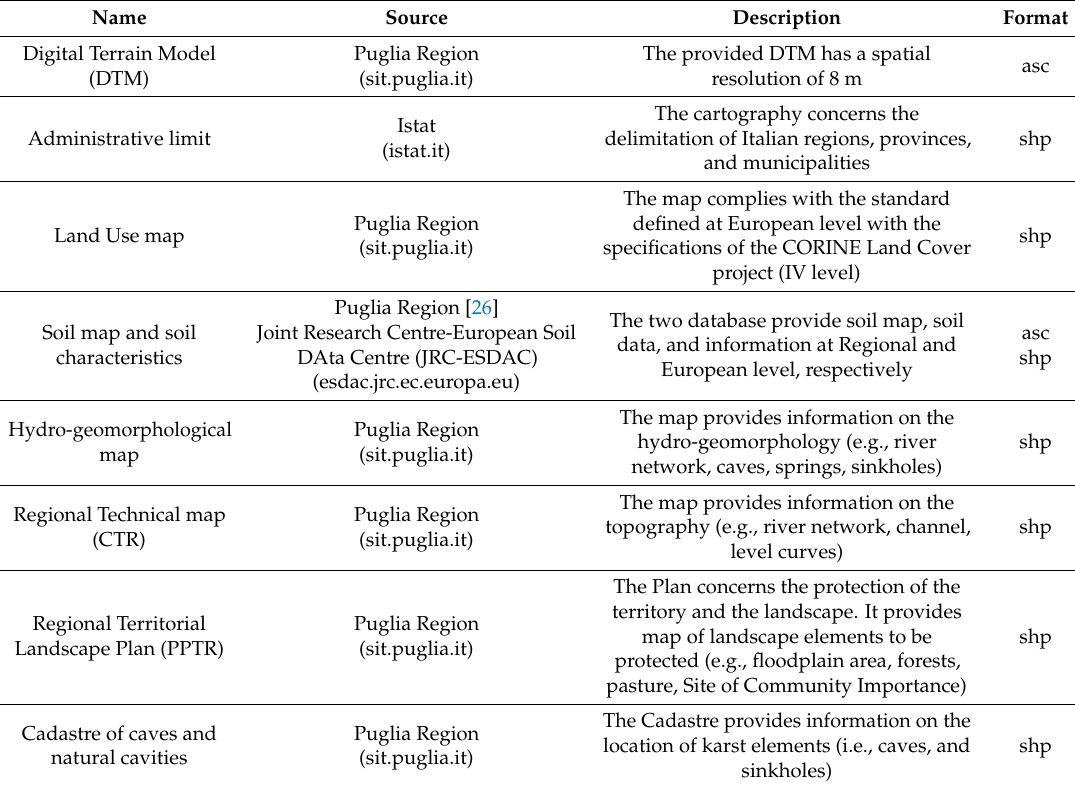
Table A1. Examined